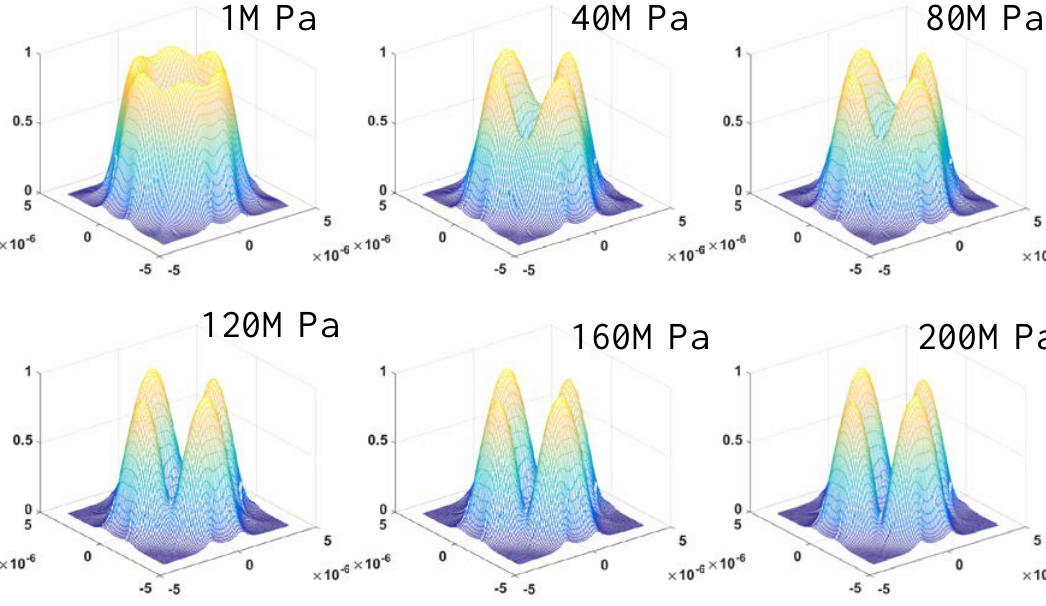
Figure 7. The normalized intensity distribution for the even mode of HE31 under 1–200 MPa stress in the y direction.